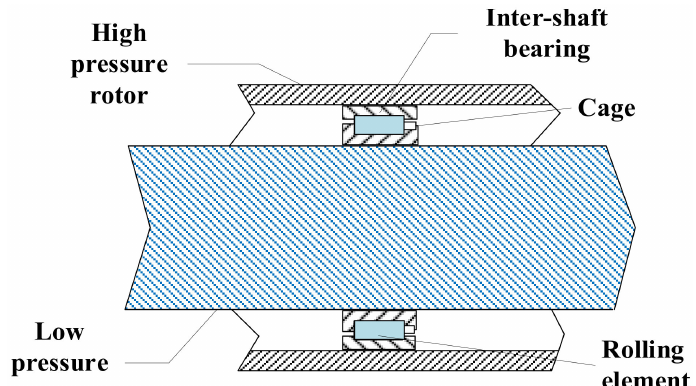
Figure 1. Supporting form of inter-shaft bearing.